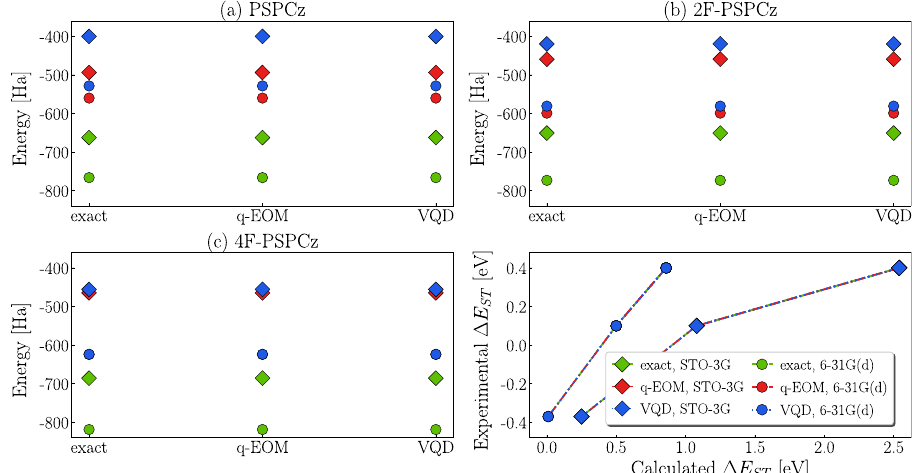
Fig. 3 Electronic energies of the S 0 , T 1 , and S 1 states of PSPCz molecules, in Hartree (Ha), and correlations of predicted and experimental energy gaps, in electronvolts (eV), using the statevector simulator. Energies of a PSPCz, b 2F-PSPCz, and c 4F-PSPCz ground and excited states from exact diagonalization, qEOM and VQD calculations with the statevector simulator using the STO-3G (represented by bars) and 6- 31G(d) basis sets (represented by circles). d Correlations between Δ E ST from spectra experiments and exact diagonalization, qEOM-VQE and VQD calculations on the statevector simulator using the STO-3G and 6-31G(d) basis